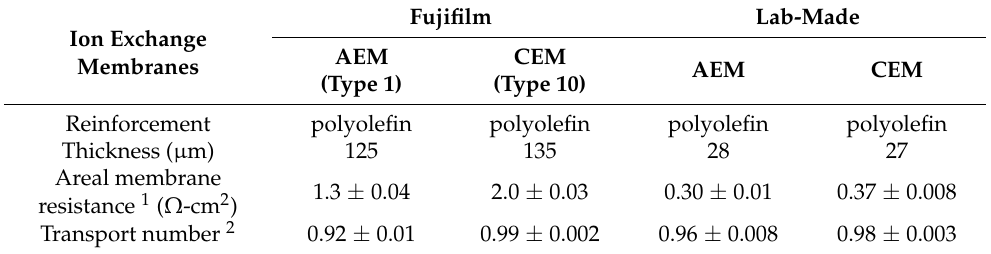
Figure 1. Chemical structures of ion exchangeable polymers of two lab-made ion exchange mem- branes: ( a ) crosslinked poly (ethylenesulfonic acid) and ( b ) quaternized poly (styrene-co-ethylene glycol dimethacrylate). Table 1. Properties of ion exchange membranes used in reverse electrodialysis [14,18,22].